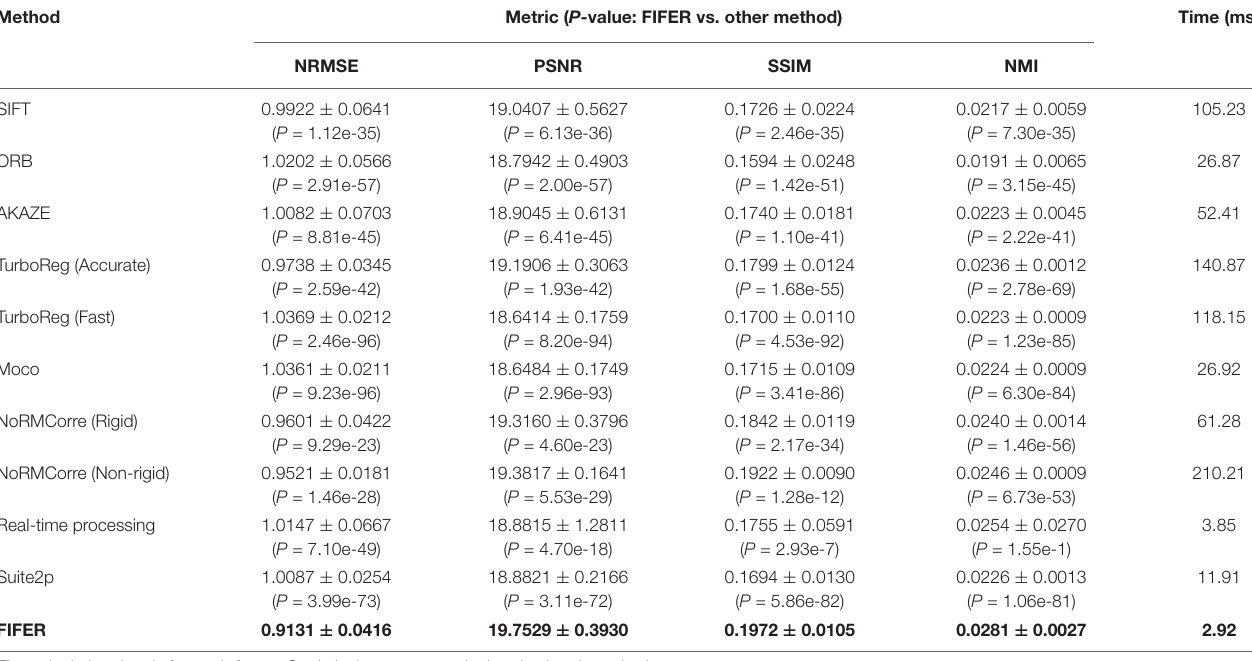
TABLE 1 | Comparison of fast image feature extraction and registration (FIFER) with other methods (Mean ± SD) for neuronal population imaging dataset ( n = 200 frames, 600 × 600 pixels for each frame). Method Metric ( P -value: FIFER vs. other method)